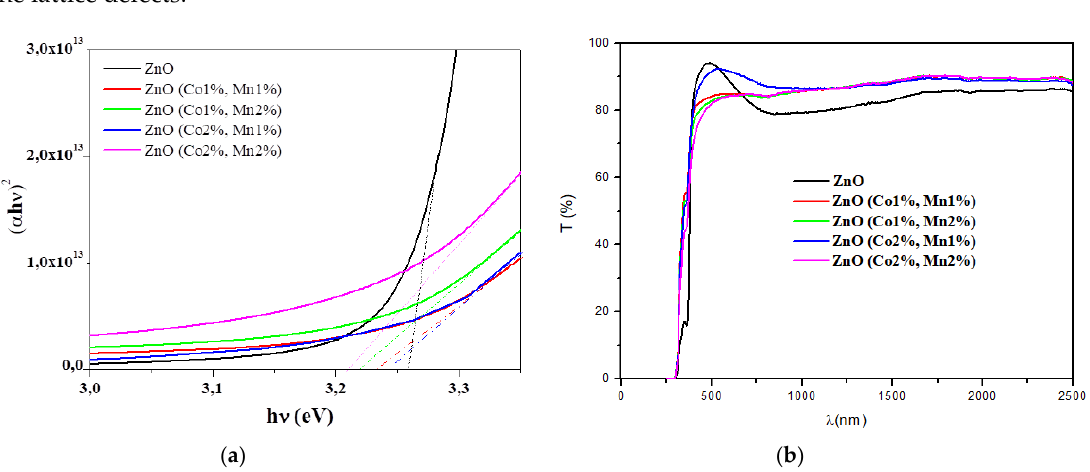
Figure 4. ( a ) Transmittance (T) spectra; ( b ) ( α h ν ) 2 vs. the incident photon energy (h ν ) of the ZnO and (Co, Mn) co-doped ZnO samples.